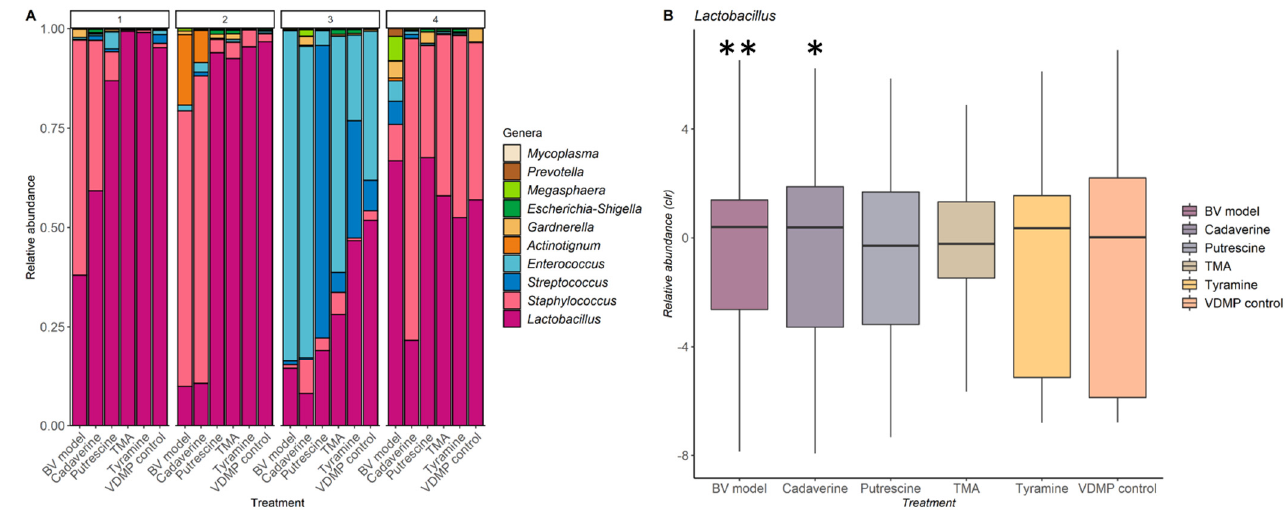
Figure 5. Impact of biogenic amines on the vaginal microbiota. ( A ) Bar plot of relative abundances. Each colour represents a genus and top numbers indicate each subject from which the sample originated. X -axis denotes which treatment each swab underwent. ( B ) Relative abundances of Lactobacillus spp. in different media (centered log ratios (CLR) are plotted). (* p ≤ 0.05 and ** p ≤ 0.01).